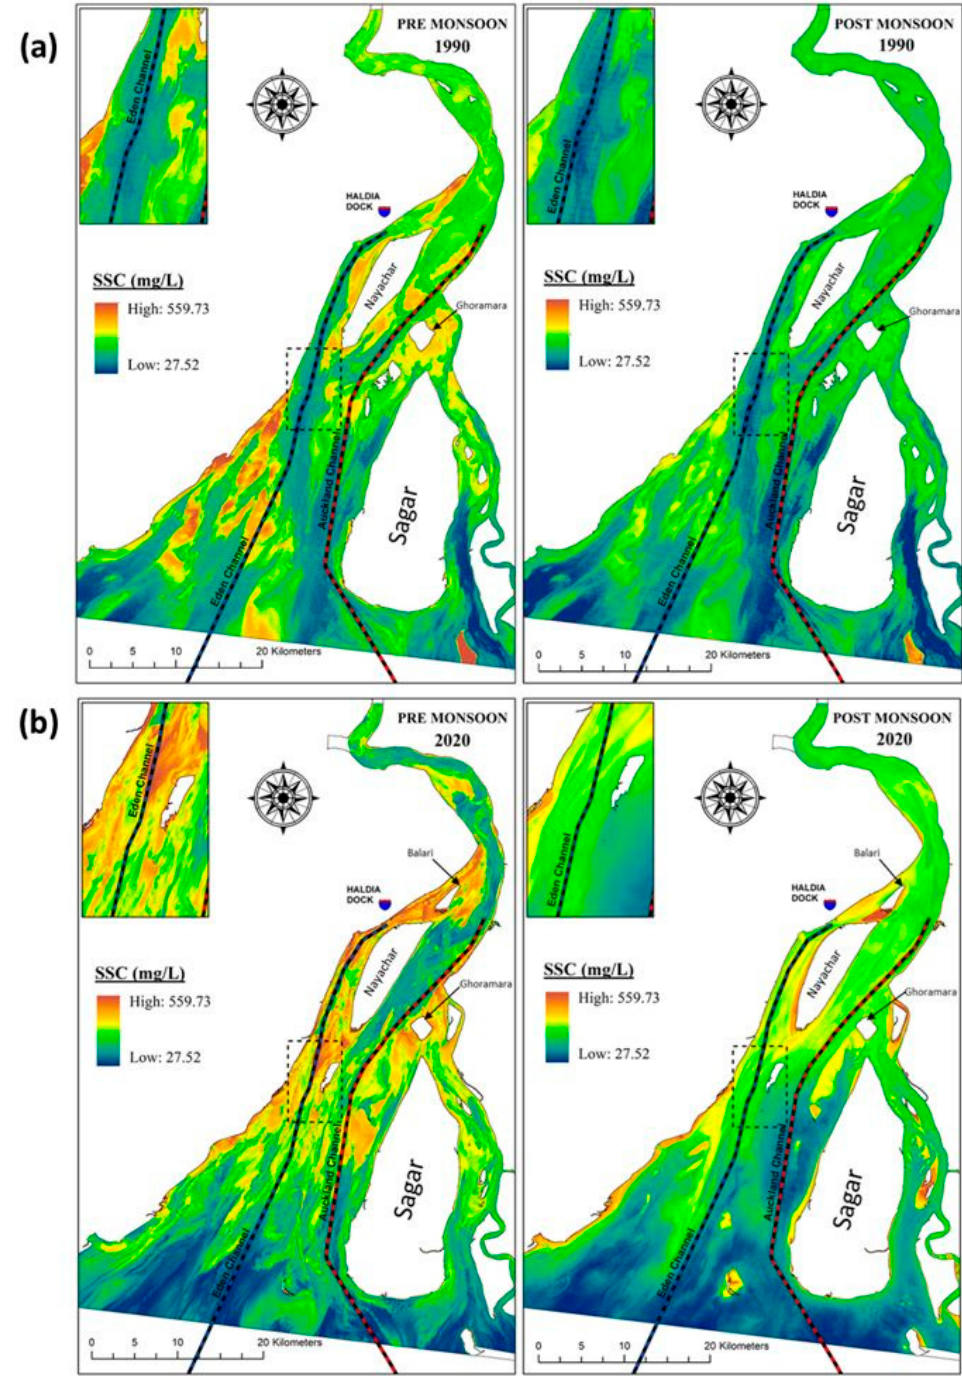
Figure 7. Pre-monsoonal and post-monsoonal distribution of SSC on Bhagirathi-Hugli River estuary during 1990 ( a ) and 2020 ( b